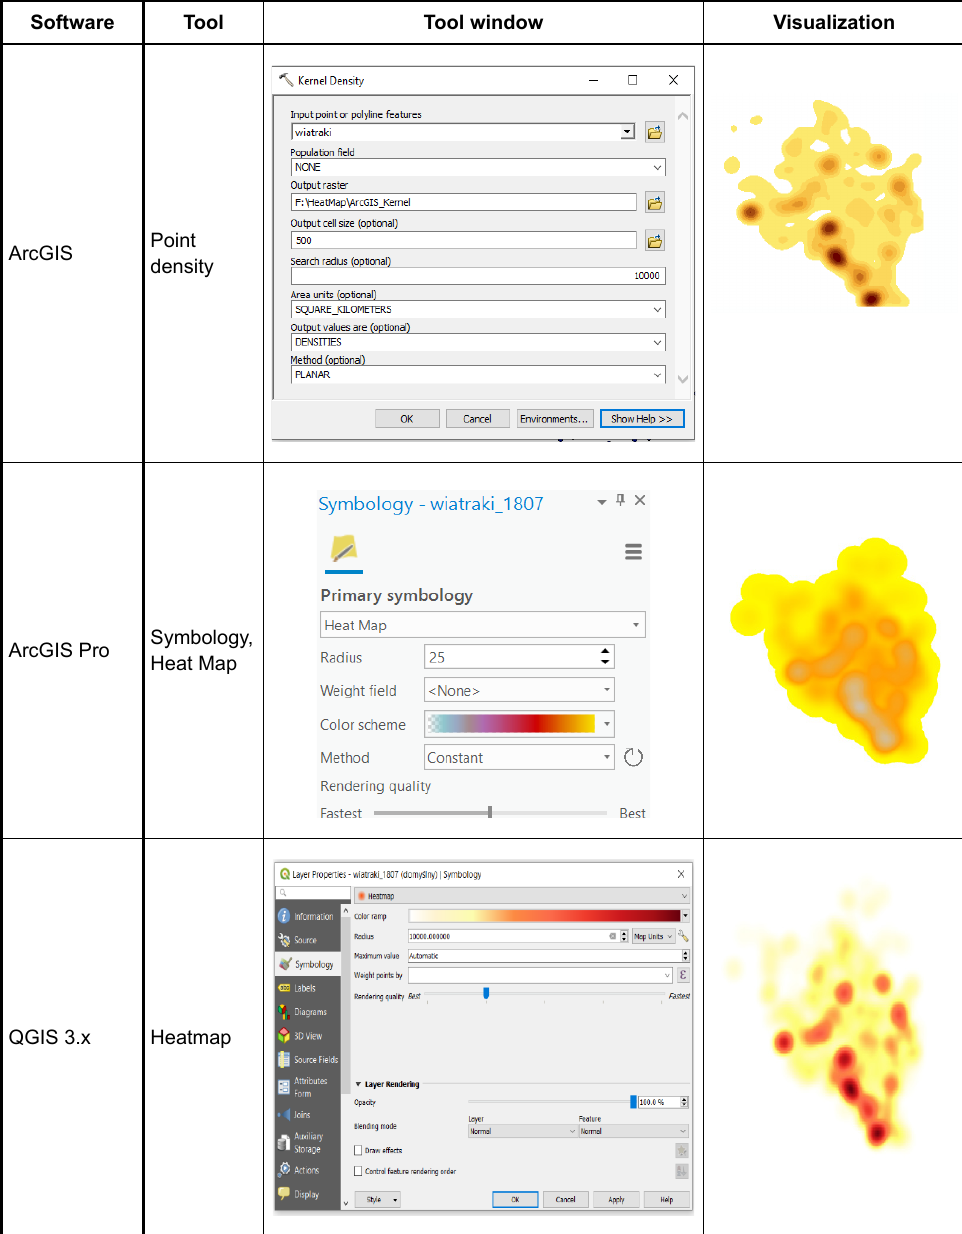
Table 1. View of the comparable Heat Map development tools and their visualization (own elaboration)